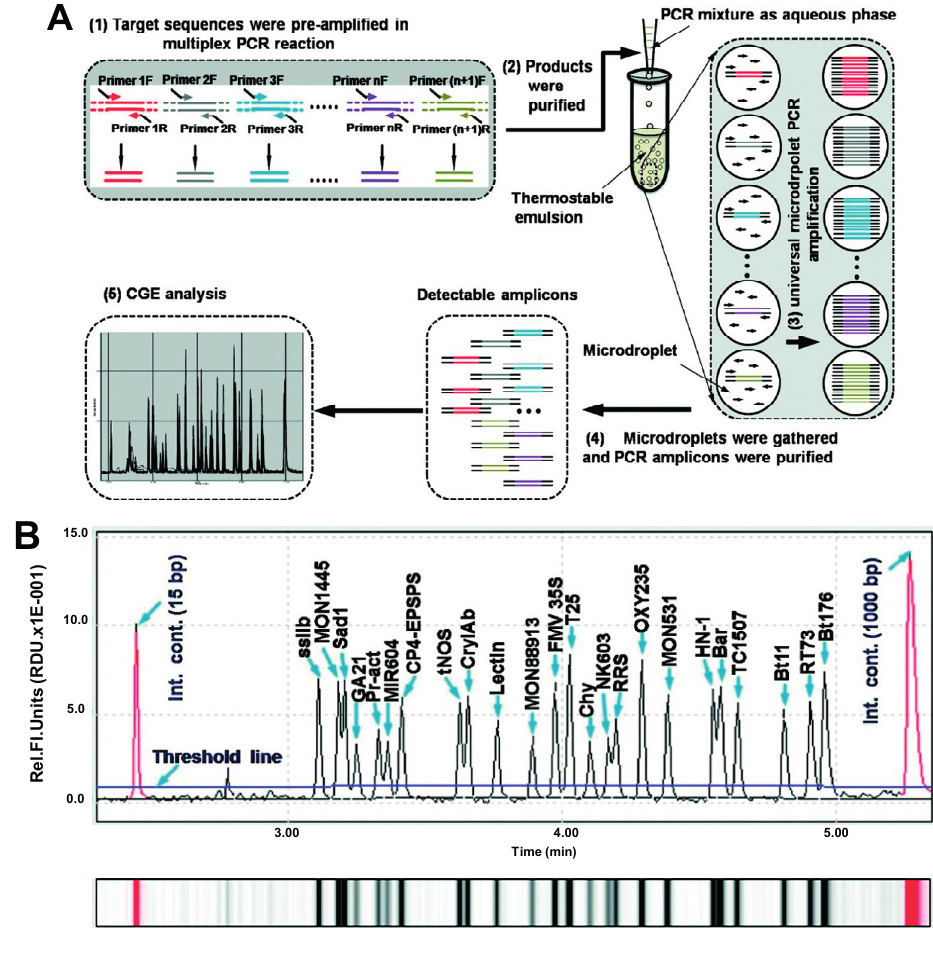
Figure 2. ( A ) Schematic diagram of the multiplex Microdroplet PCR Implemented Capillary gel electrophoresis (CGE) (MPIC) assay. (1) Target-specific DNA products with universal tails on each side were generated in multiplex PCR preamplification, using bipartite primers; (2) The products of the multiplex preamplification were purified and used as templates in the second step, universal microdroplet PCR amplification, using universal primer pairs; (3) The microdroplet PCR was performed, employing the universal primer pair Uni-F/R in the emulsion droplets; (4) The w/o emulsion was centrifuged to gather all microdroplets, and DNA fragments were purified for subsequent CGE-based detection; (5) Detectable amplicons were analyzed by CGE; ( B ) Capillary gel electrophoresis analysis of the 24-plex MPIC assay for detection of 14 different GM events using 24 bipartite primer pairs. Amplicons were produced from a GM DNA solution mixture containing 1.6% of each of the 14 different GM events. The peaks of the amplicon are indicated by blue arrows. The profile shown under the electrophoregram is the simulated gel image corresponding to the results of the capillary gel electrophoresis analysis. Reprinted with permission from